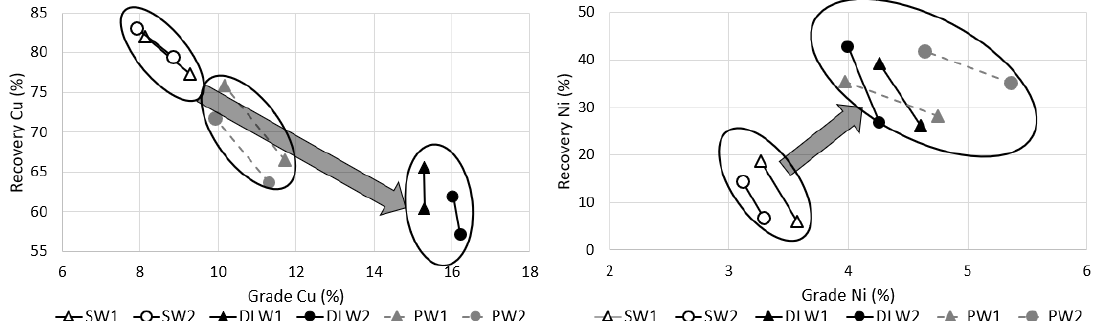
Figure 7. Recovery-grade curves for the Cu and Ni flotation performed with starting water (SW), dissolution loop water (DLW), and process water (PW).